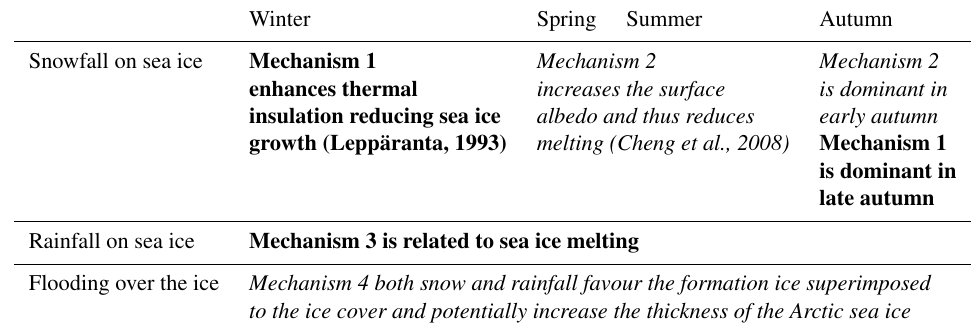
Table 1. Summary of the main contrasting mechanisms of the impact of precipitation on ice cover. Those mechanisms favouring ice melting are shown in bold and those favouring ice growth are shown in